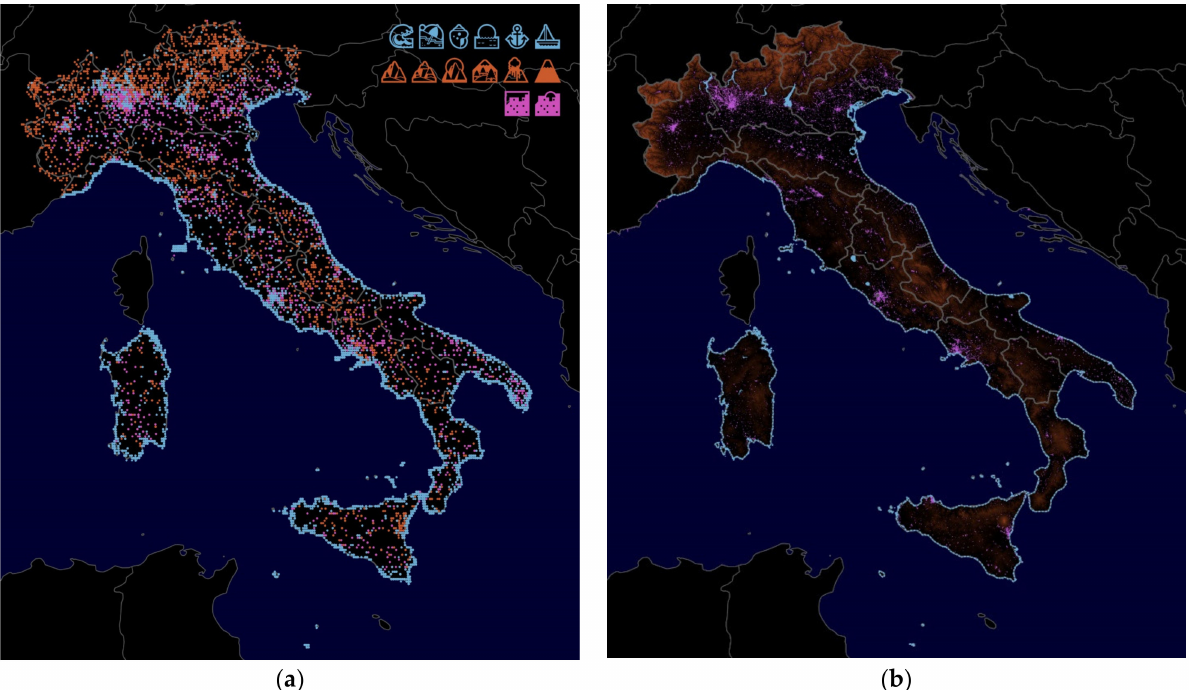
Figure 10. (a) Spatial distribution of location-specific emojis in Italy representing montane, urban and maritime environ- ments; (b) elevation [49], urban zones, large lakes and coastline [50] of Italy in corresponding